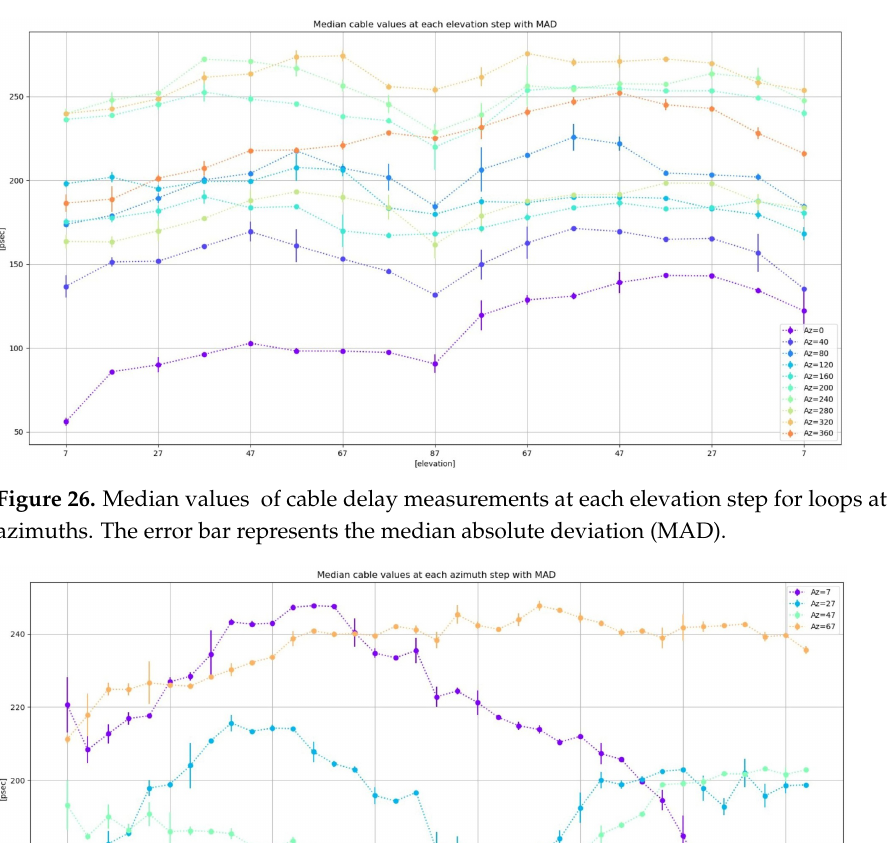
Figure 25. Zoom of cable delay versus azimuth ( top ) and elevation ( bottom ) during the second part of the test.